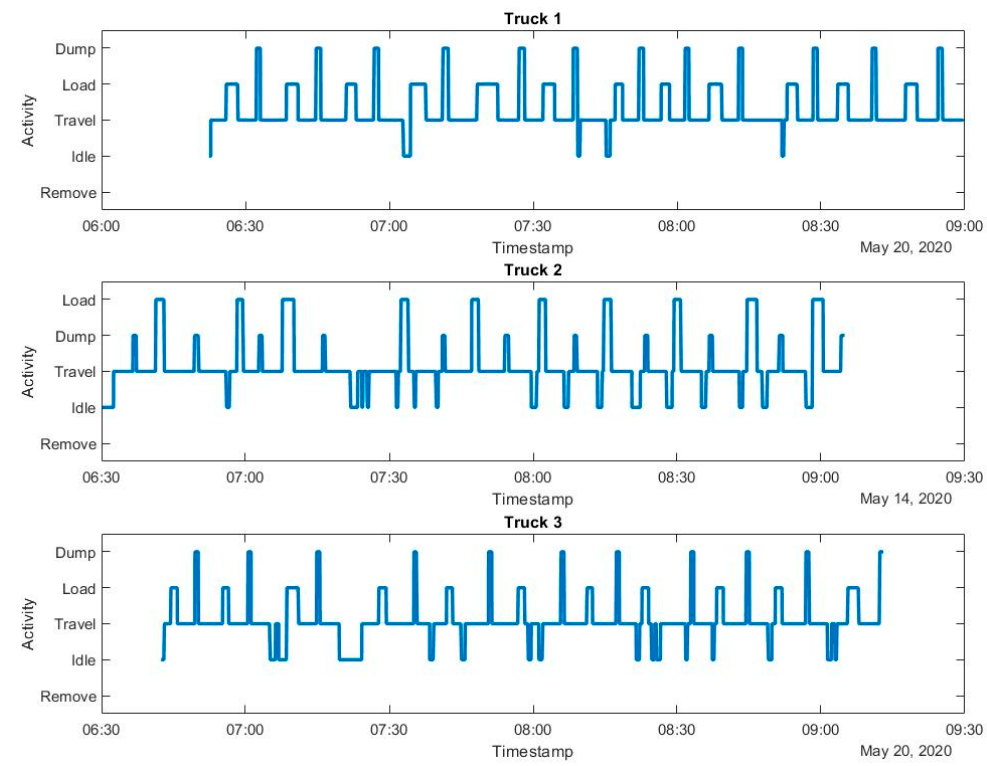
Figure 8. Activity profile of three trucks.